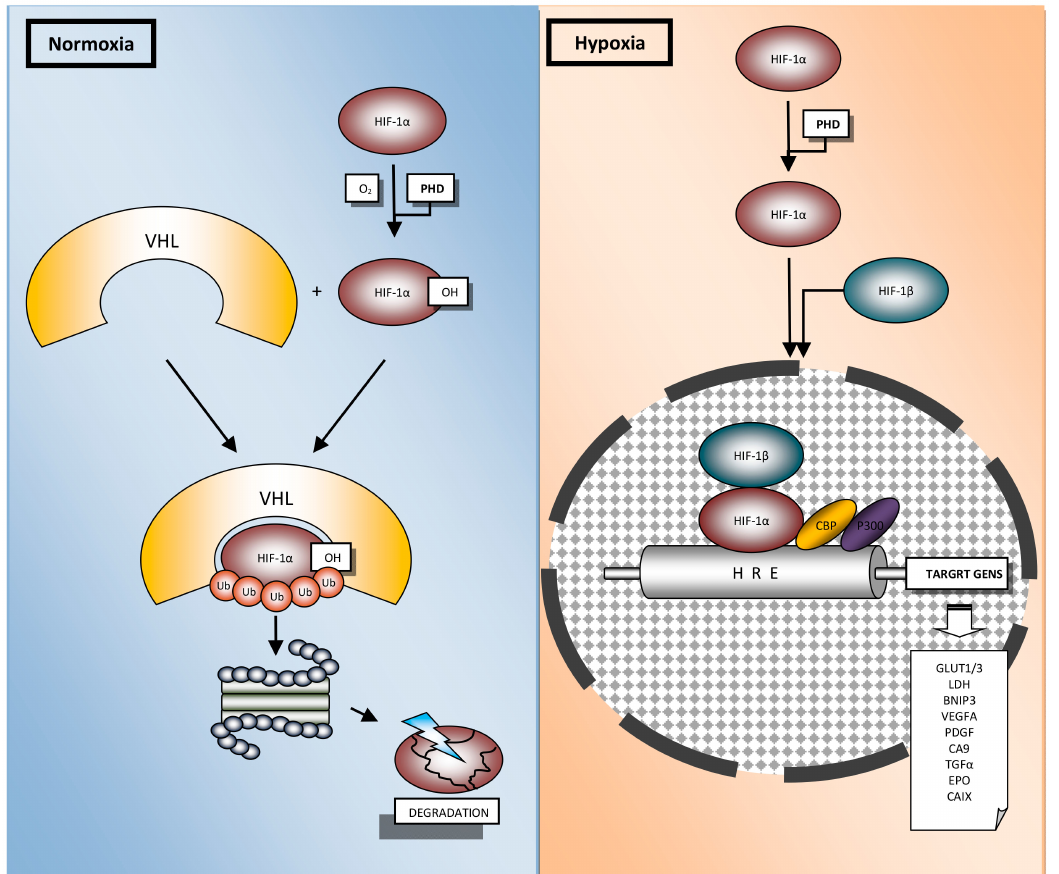
Figure 2. Regulation of HIF-1 α in physiological oxygen concentration (normoxia) and hypoxia. In normoxia, HIF-1 α is rapidly degraded via ubiquitin-mediated process. The hydroxylation of HIF-1 α by prolyl hydroxylase domain proteins (PHD), with use of oxygen, leads to interaction with Von Hippel–Lindau (VHL), addition of ubiquitin (Ub) and HIF-1 α proteasomal degradation. Under oxygen deprivation, HIF-1 α is not targeted for degradation. Hypoxia leads to HIF-1 α accumulation in the cytoplasm, whence it is translocated to the nucleus where it binds with HIF-1 β . α and β subunits form the heterodimer HIF-1, which joins to the hypoxia response element (HRE) and recruits co-activators (CBP, p300) at the HRE to induce the transcriptional activity of target